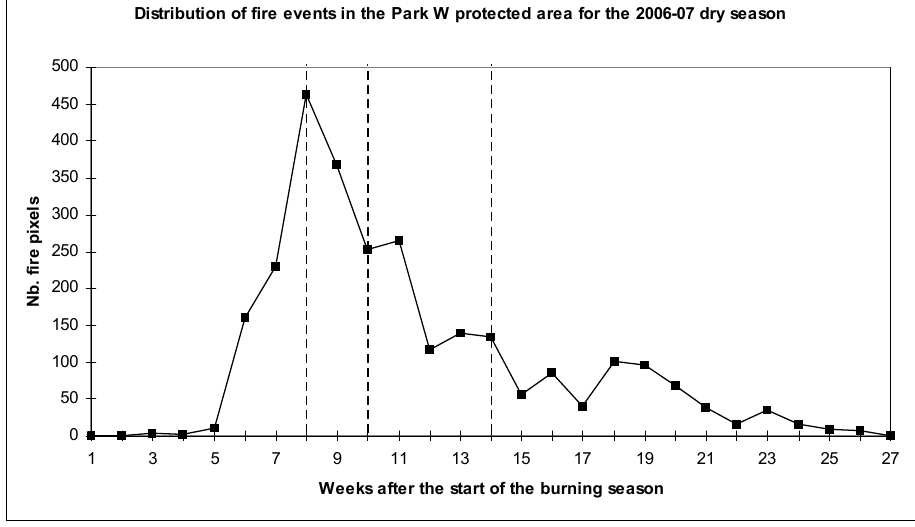
Figure 2. Temporal distribution at a weekly time step of the fire activity in the Park W transboundary national park (Benin, Burkina Faso and Niger) for the 2006–2007 dry season. The vertical lines show from left to right when the cumulative number of fire pixels equal 25%, 50% and 75% of the seasonal